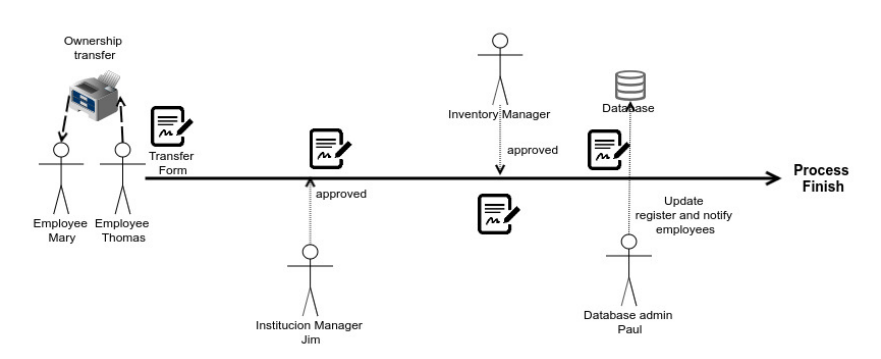
Figure 1. Problem of ownership